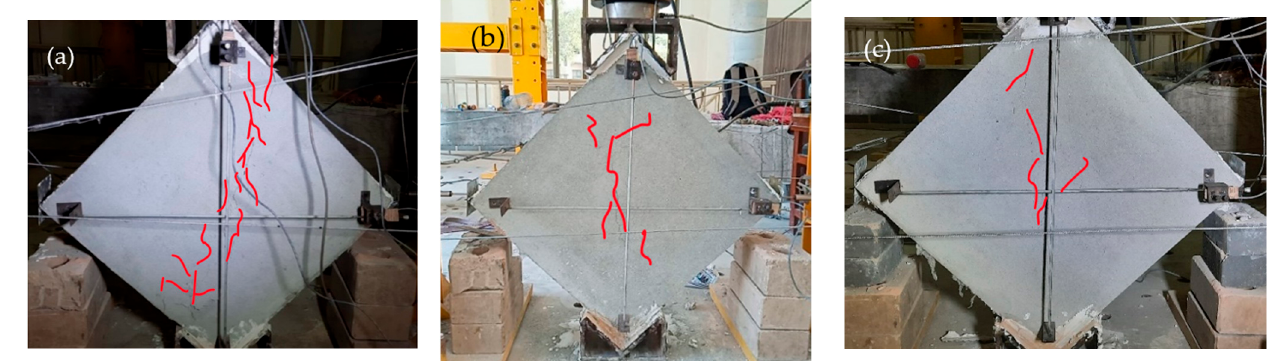
Figure 12. Failure pattern of SCS-reinforced specimens.